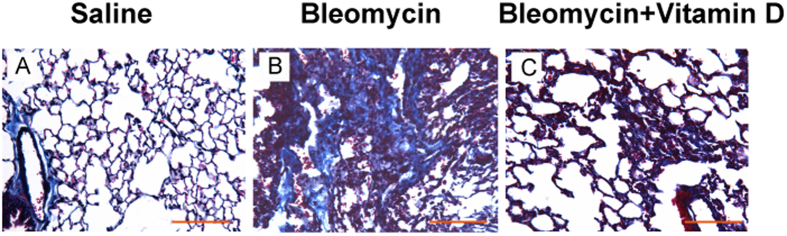
Masson trichrome staining of representative lung tissue on day 21.No significant fibrosis was found in the control group ((A), Masson). More collagen deposition/fibrosis in the pulmonary interstitium was found in the bleomycin group ((B), Masson). Compared with the bleomycin group, collagen deposition in the vitamin D group was significantly reduced ((C), Masson). The experiment was repeated at least three times. Bars = 100 μm